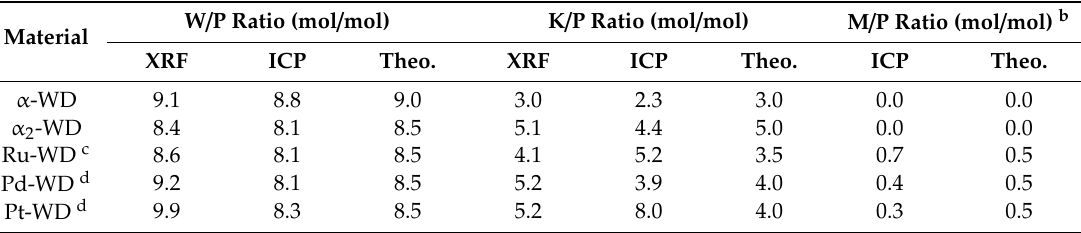
Table 4. XRF and inductive-coupled plasma (ICP-OES) results of the synthesized WD materials a .